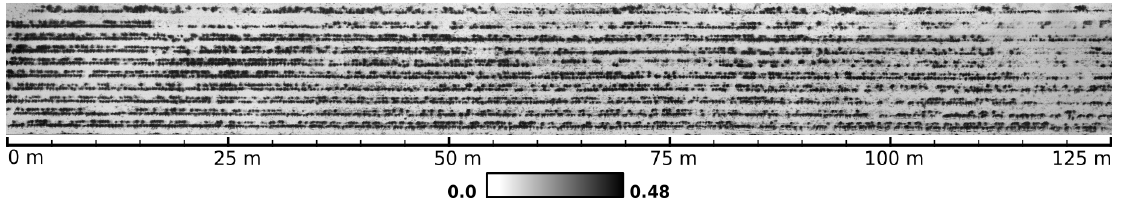
Figure 10. Normalized difference vegetation index (NDVI) levels for the study